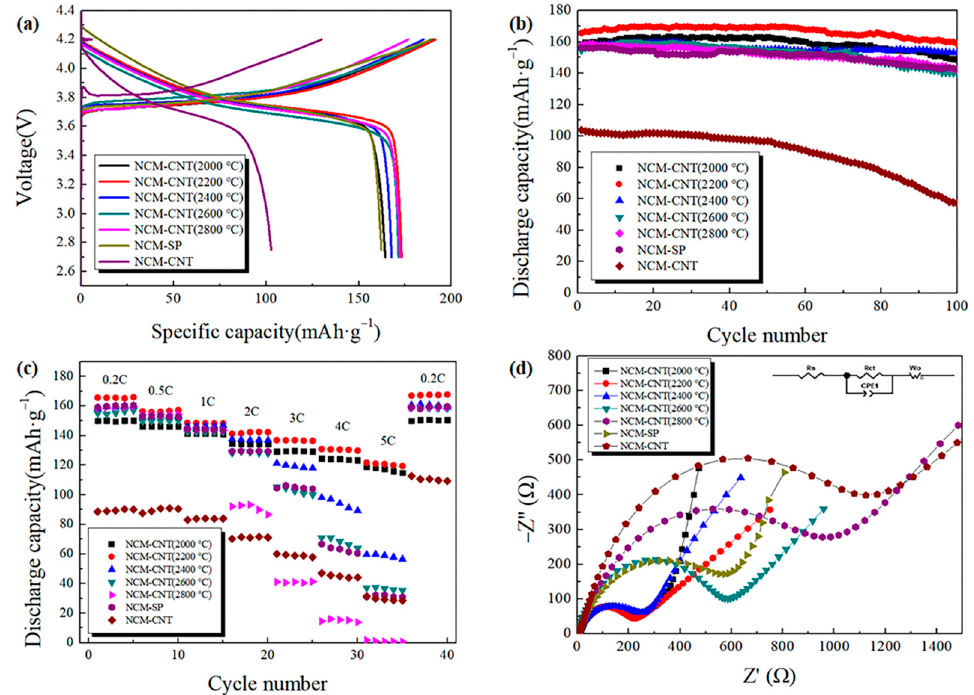
Figure 6. Electrochemical properties of LiNi 0.5 Co 0.2 Mn 0.3 O 2 cathodes using MWNTs slurry made by abrasive dispersion at different annealing temperatures. ( a ) Initial galvanostatic charge–discharge profiles at 0.1 C; ( b ) cycling performance at 0.5 C; ( c ) rate performance of all samples; ( d ) the EIS data of all samples.